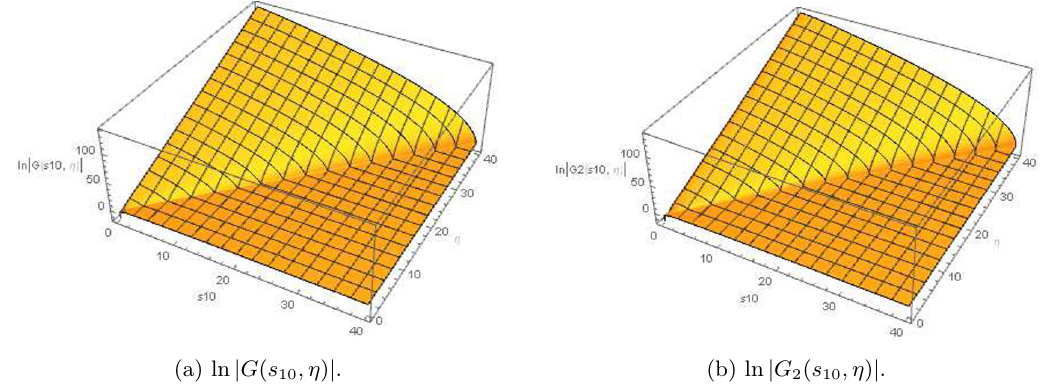
Figure 6. The plots of logarithms of the absolute values of the two polarized dipole amplitudes G and G 2 versus s 10 and η , for the 0 s 10 , η η max = 40 range. The amplitudes are computed ≤ ≤ numerically using step size δ = 0 . 05. The inhomogeneities near the η = s 10 line result from the Born initial conditions and the discretization